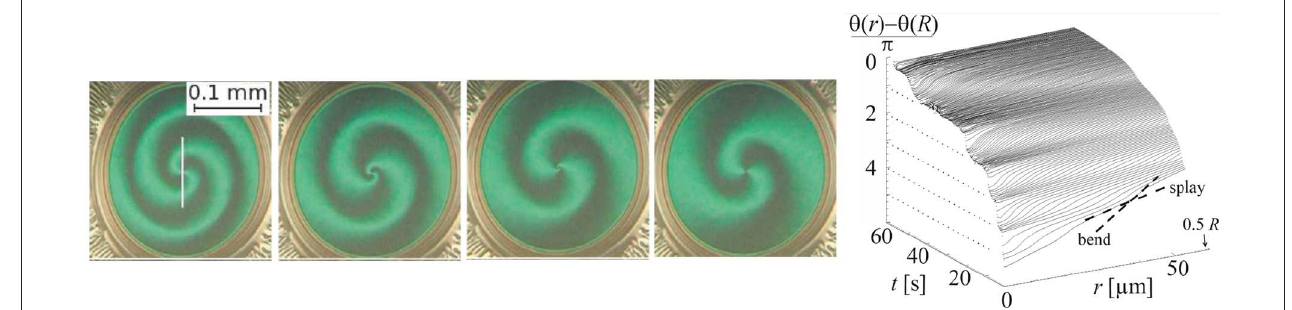
FIGURE 10 | Central 1 defect in a radially distorted director field within a SmC FSF. Images taken during relaxation in 4 s steps. The phase of the defect relative to + the film border is initially 2 π , it slips to π in the last image. Dark and bright green regions reflect horizontal and vertical c-director orientations, respectively, in these pictures. The relief on the right shows the time dependence of the radial phase profile in the film center. Image adapted from Eremin et al.